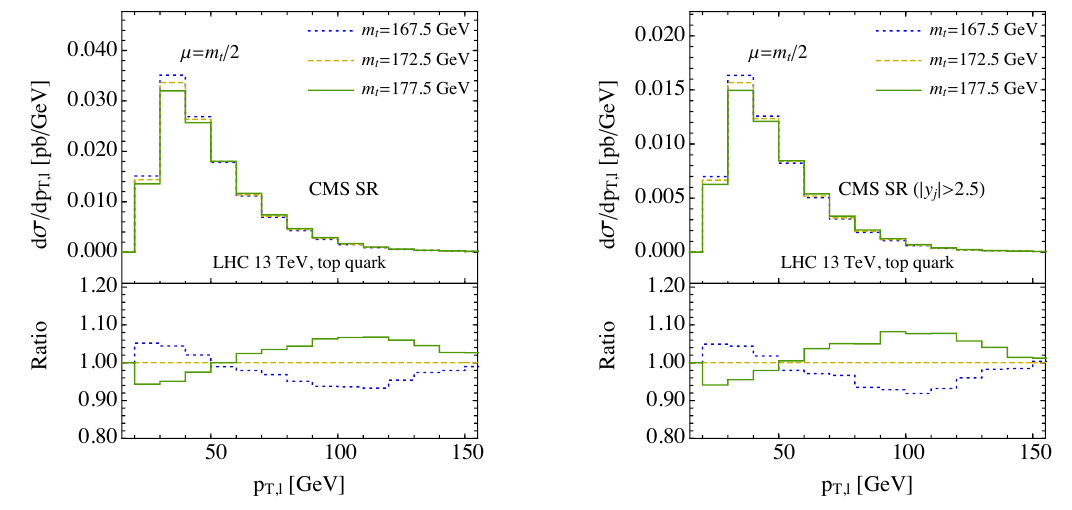
Figure 1 . Transverse momentum distribution of the charged lepton within the two fiducial regions at NLO in QCD for different choices of top-quark mass, calculated in the 5FS for LHC 13 TeV.